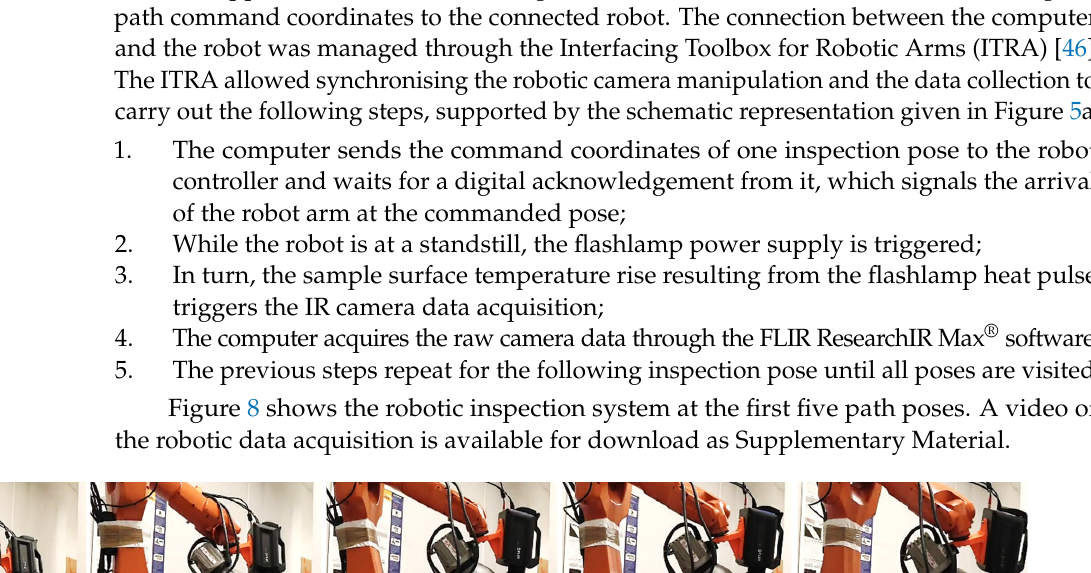
Figure 7. MATLAB-based graphic user interface for robot path-planning, simulation and control.